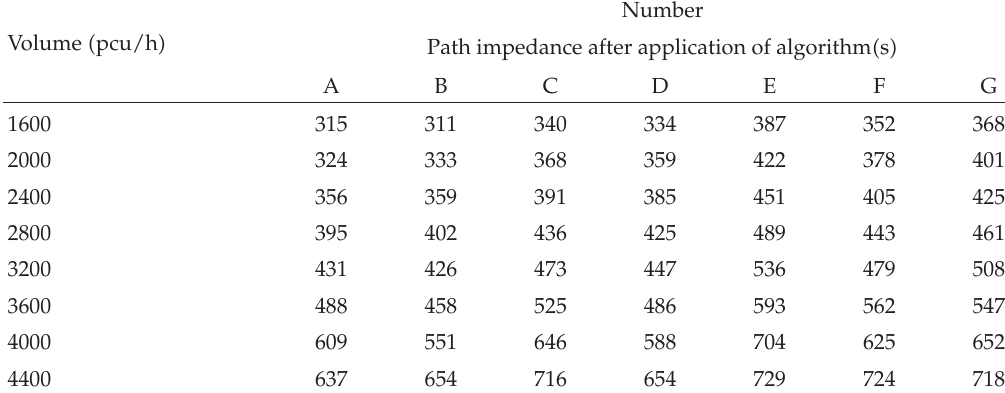
Table 2: The path impedance based on simulation data.